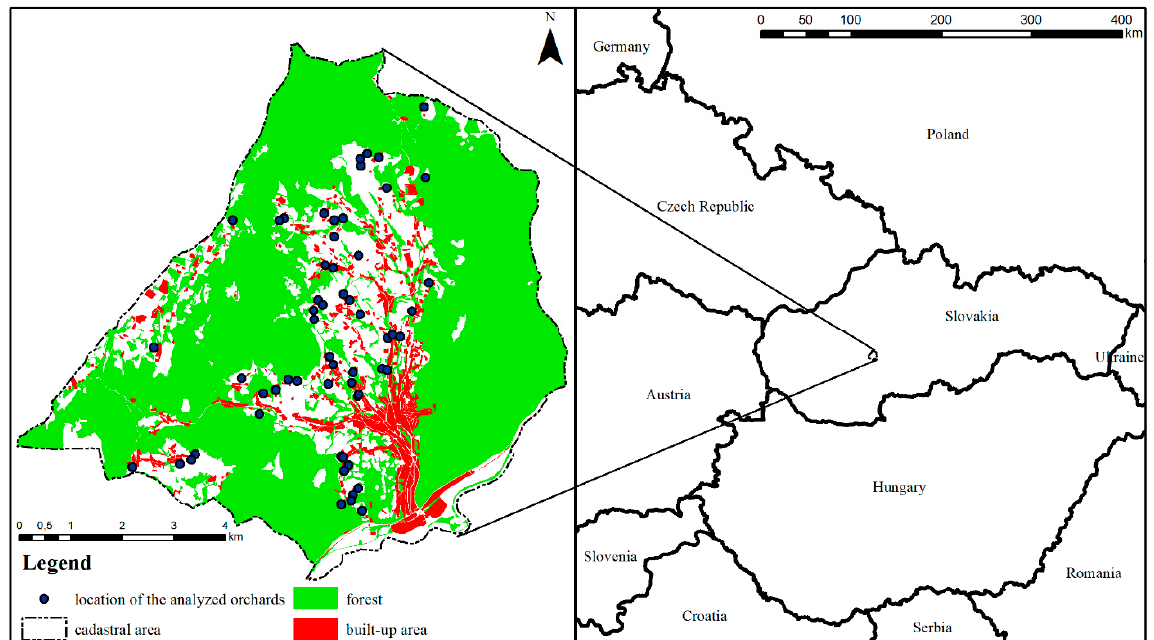
Figure 1. Study area and location of the analyzed orchards.